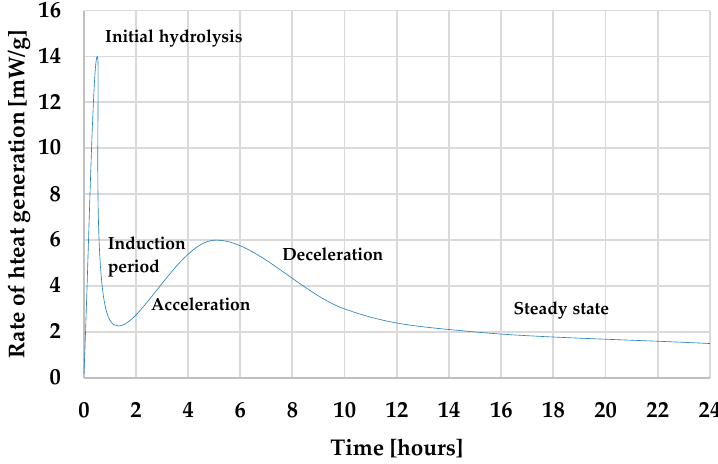
Figure 1. An example of the rate of heat development versus hydration time curve.